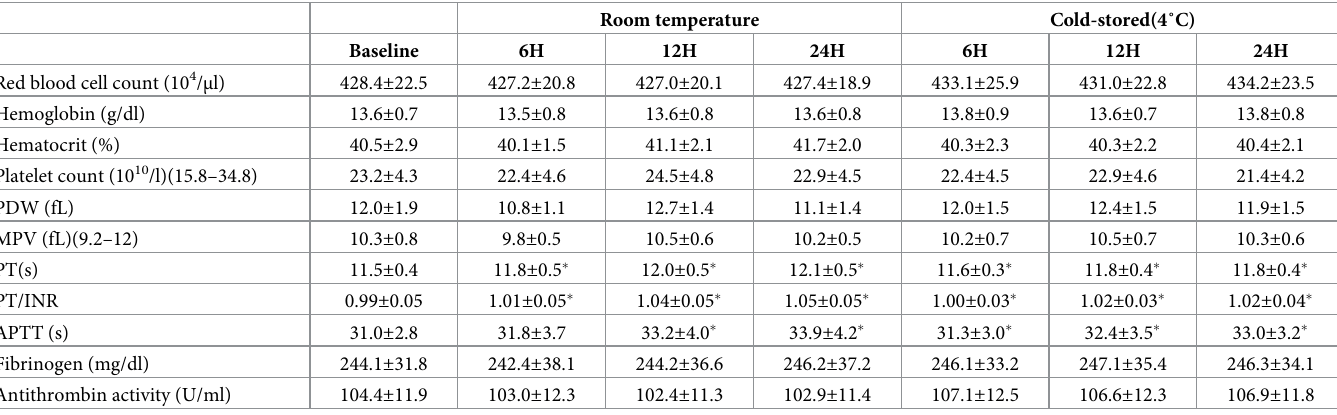
Table 2. The mean complete blood counts and coagulation profiles during storage ( n = 9).